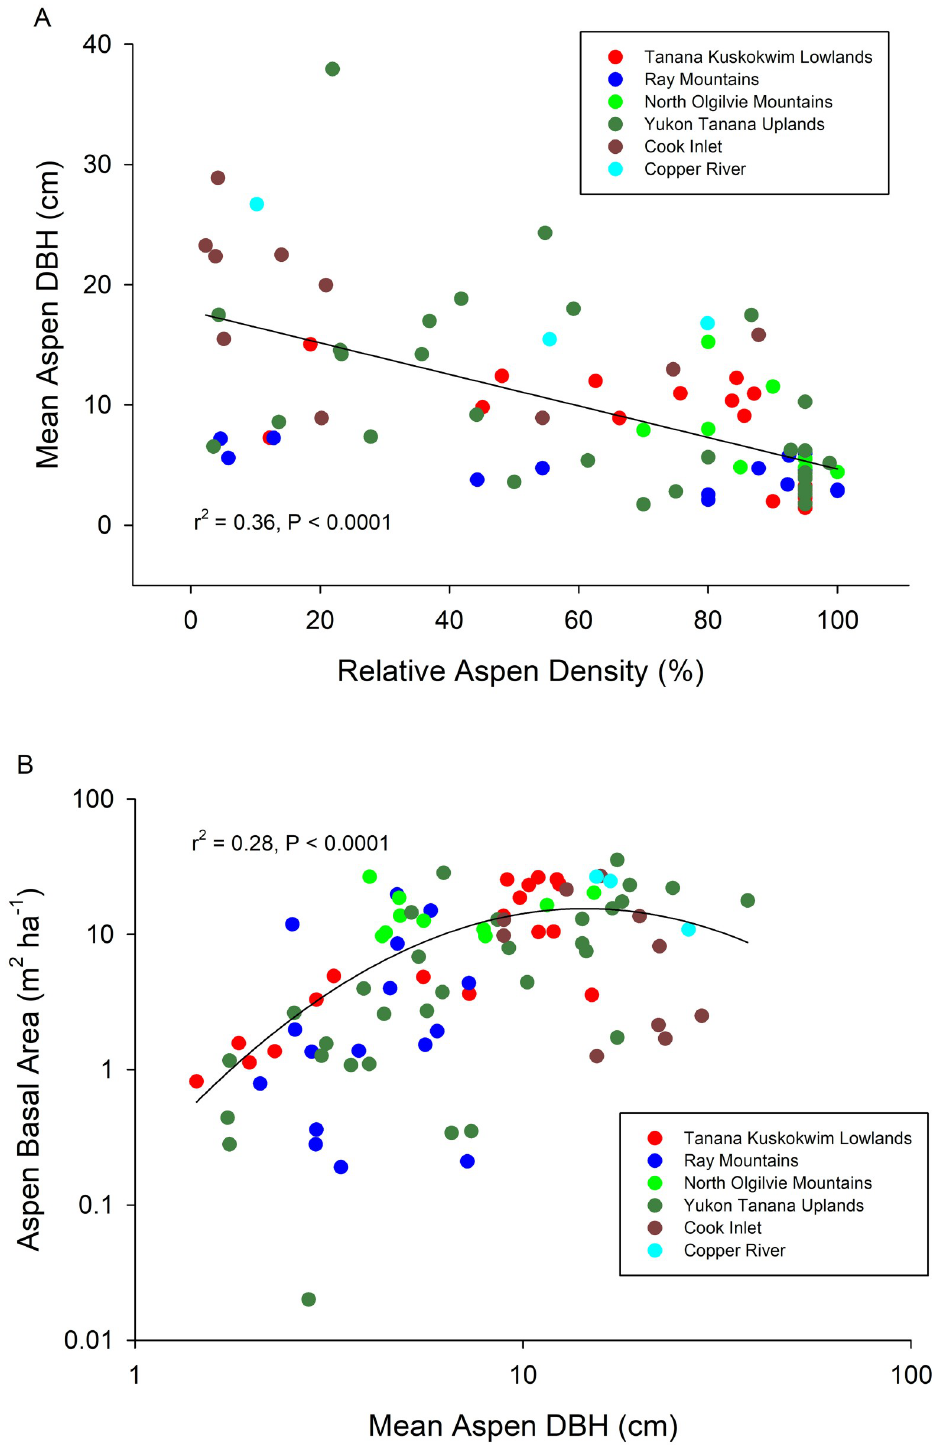
Fig 2. Relationships between stand structural characteristics across the 88 study sites. Mean aspen DBH vs. percentage of trees that were aspen (= relative aspen density) across stands where aspen grew with white spruce, black spruce, Alaskan paper birch, or a combination (A) and aspen basal area vs. mean aspen DBH (B) across study sites.